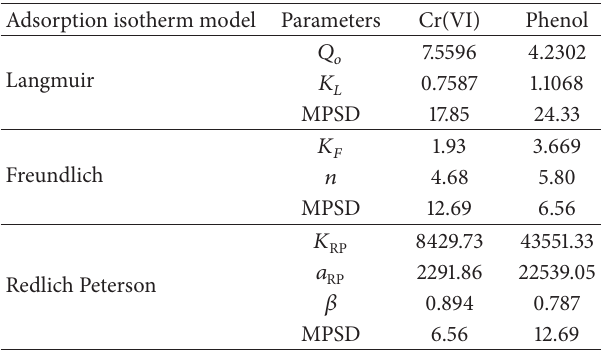
Table 1: Parameters from single component modelling for adsorp- tion of phenol and